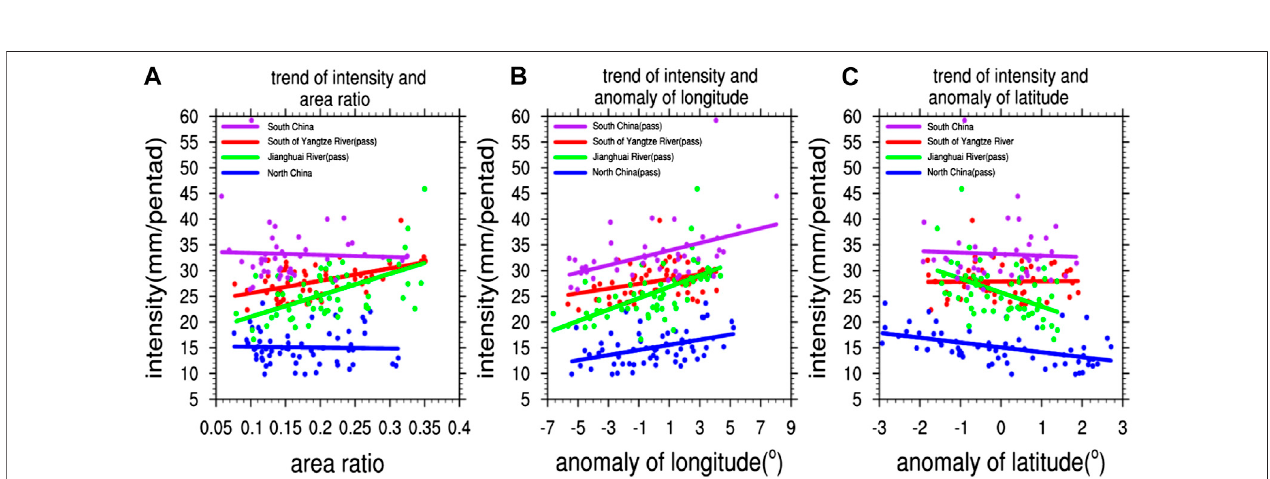
FIGURE 3 | The temporal distribution of area ratio and intensity (unit: mm per pentad) of RPEPs in the four cluster regions, SC (A) , SYR (B) , JHR (C), and NC (D) during summer, where the blue dot and red dot indicate area ratio and intensity, respectively, and the larger the dots are, the larger the area ratio and intensity are.